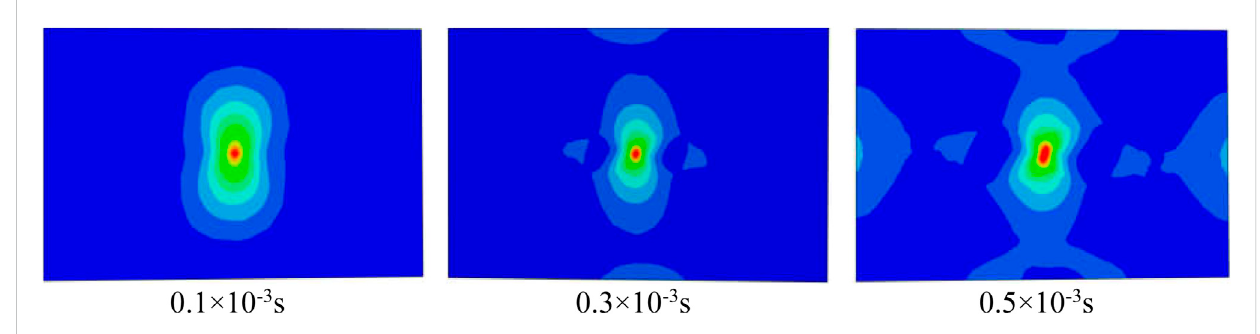
FIGURE 3 The nephogram of Mises stress distribution at the typical time moment of Sample30 when the impact energy is 20